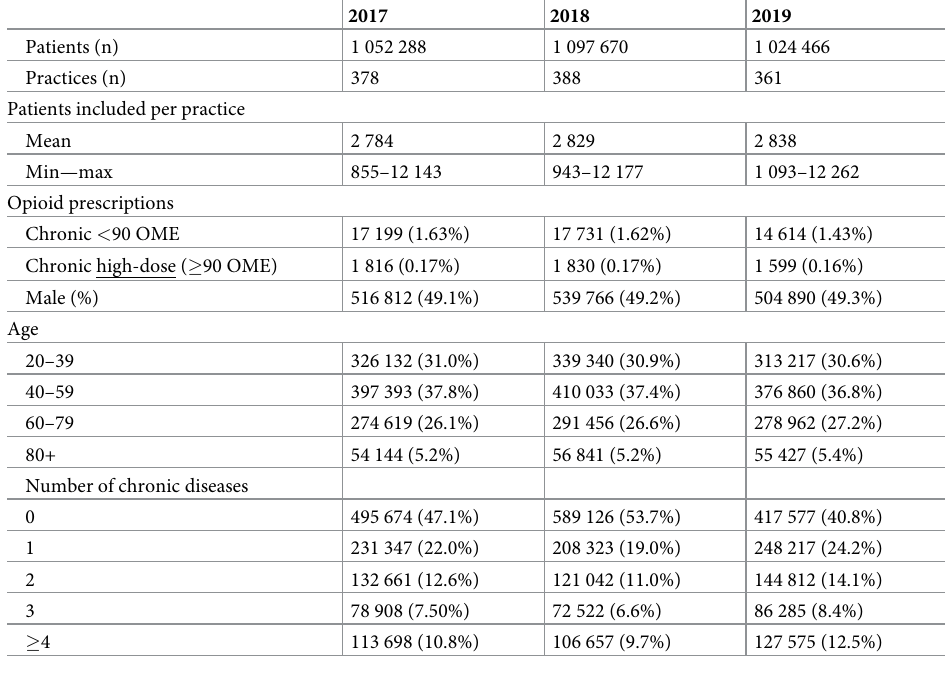
Table 1. Basic patient and practice characteristics per